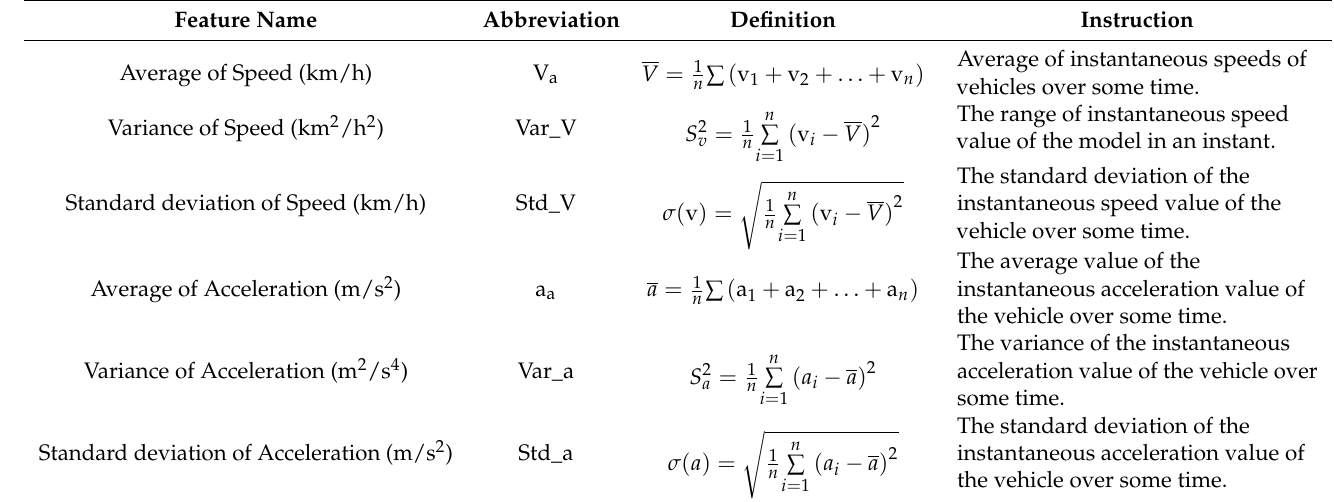
Table 3. Description of the traffic accident dataset used in the